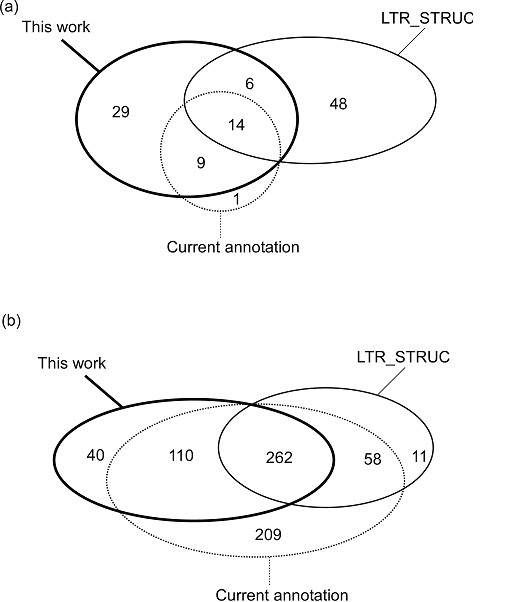
Comparison of identified LTR retrotransposons by our method and LTR_STRUC. (a) Venn diagram illustration of the comparison in C. elegans. Our method identified 23 out of 24 known elements, whereas LTR_STRUC identified 14. (b) Venn diagram illustration of the comparison in the D. melanogaster. Using only intact LTR retrotransposons, our method identified 418 out of 639 annotated elements, whereas LTR_STRUC identified 320. (c) Venn diagram illustration of the comparison in the D. melanogaster. Using both intact and solo LTR retrotransposons, our method identified 569 out of 639 annotated elements, whereas LTR_STRUC identified 320.